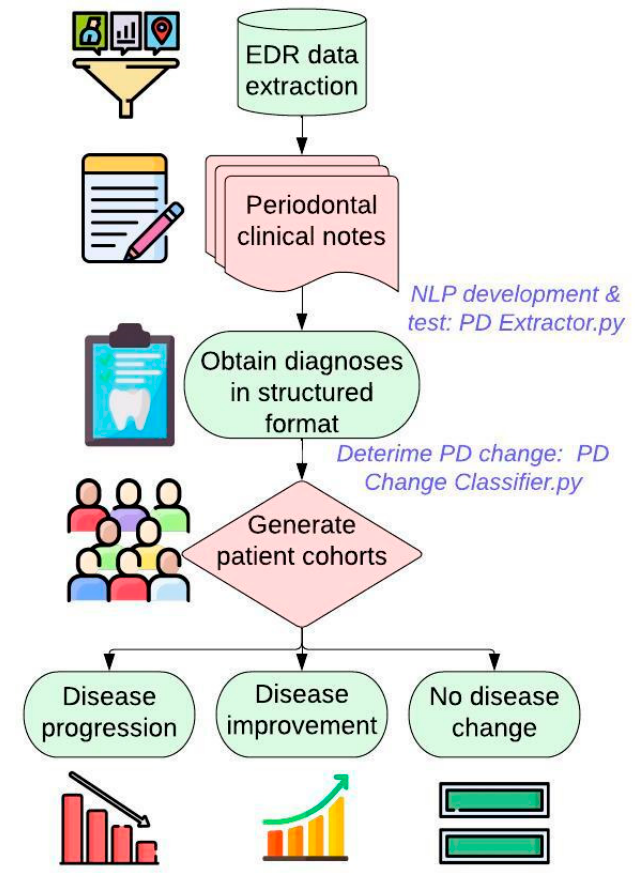
Figure 1. Developing automated computer algorithms to generate three patient